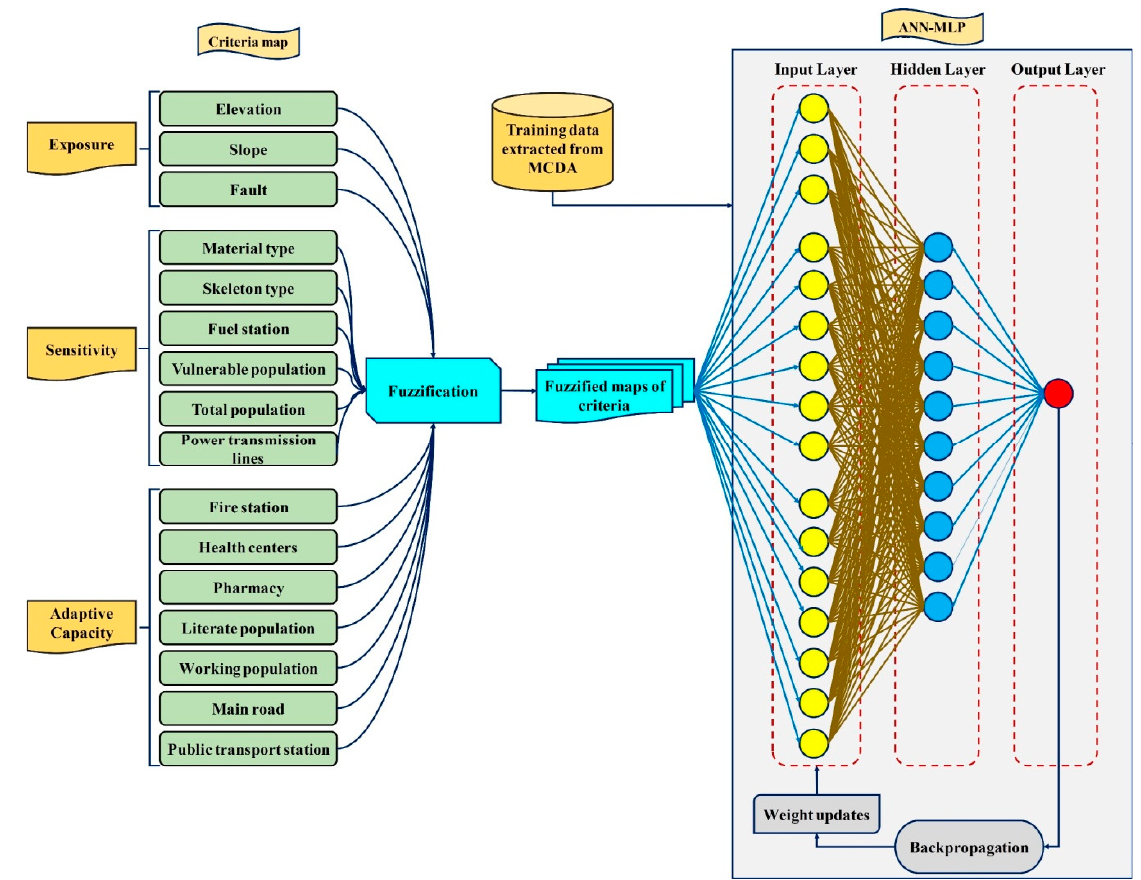
Figure 4. Architecture of multi-layer perceptron neural network .